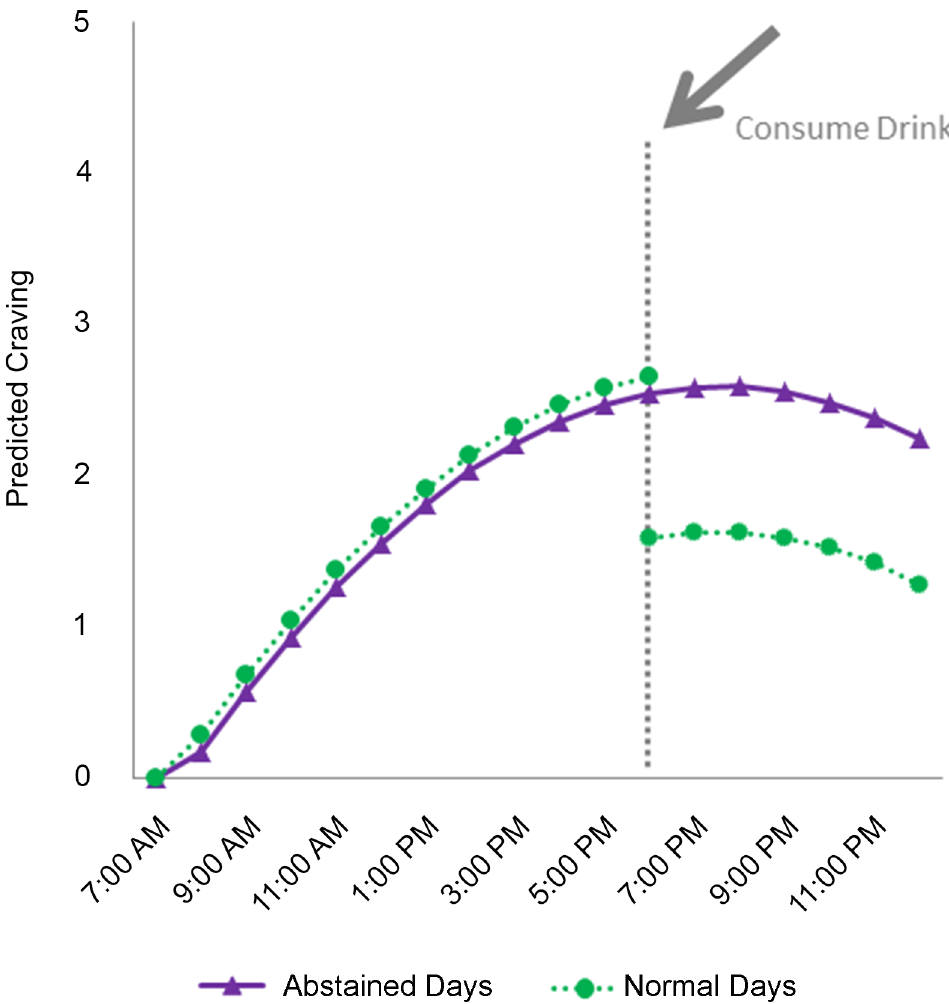
Fig 1. Estimated overall average effect across the 3-days of abstinence on craving responses by time of day and the effect of taking of drink on craving during the 3-day normal period.